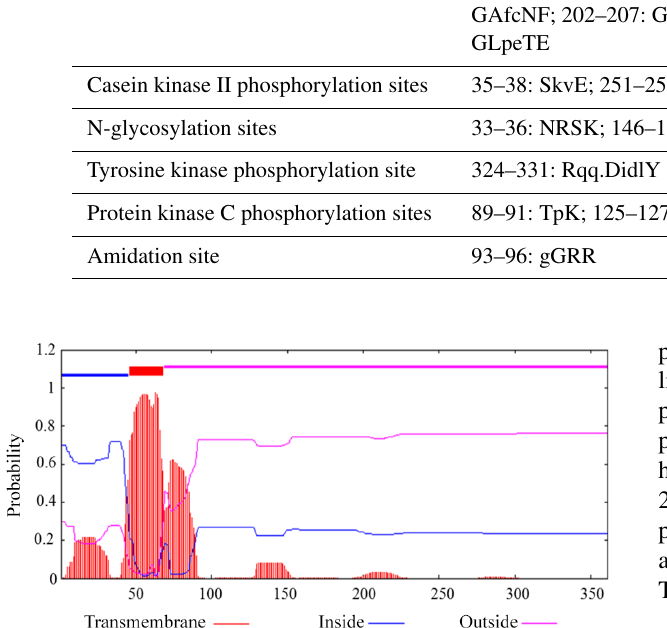
pathways of glycerophospholipid biosynthesis. Protein